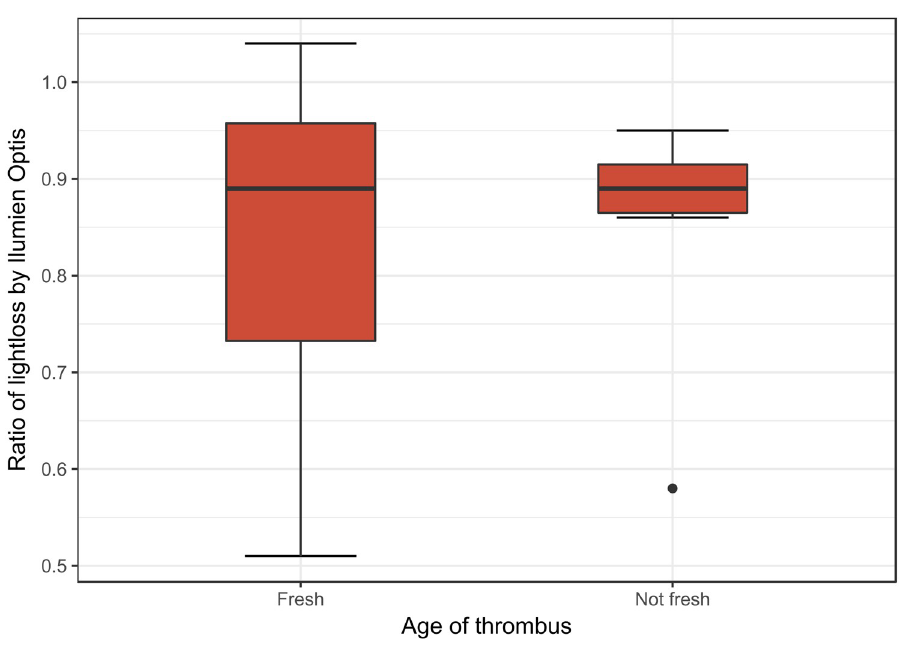
Fig 4. Ratio of lightloss by Ilumien Optis software in thrombi defined by histopathological appearance.